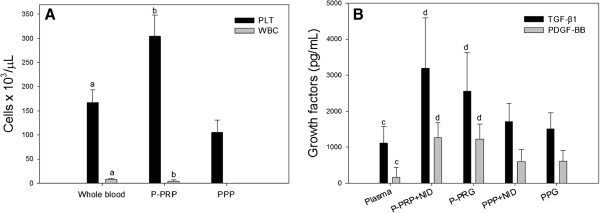
A) Platelet (PLT) and leukocyte (WBC) concentration in whole blood, P-PRP and, PPP. B) Transforming growth factor beta 1 (TGF-β1) concentrations (pg/mL) in different plasma, P-PRP plus non ionic detergent (P-PRP+NID), pure-platelet rich gel (P-PRG), PPP+NID and platelet poor gel (PPG) Bars represent the mean of n= 40±s.d. Different letters indicate significant differences between groups.